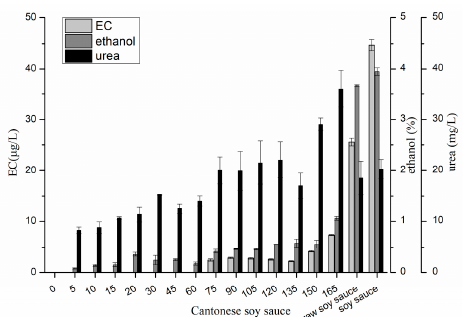
Figure 1. Changes of ethyl carbamate, ethanol and urea contents in Cantonese soy sauce (“0” on the X axis means the end of koji -making, similarly hereinafter).